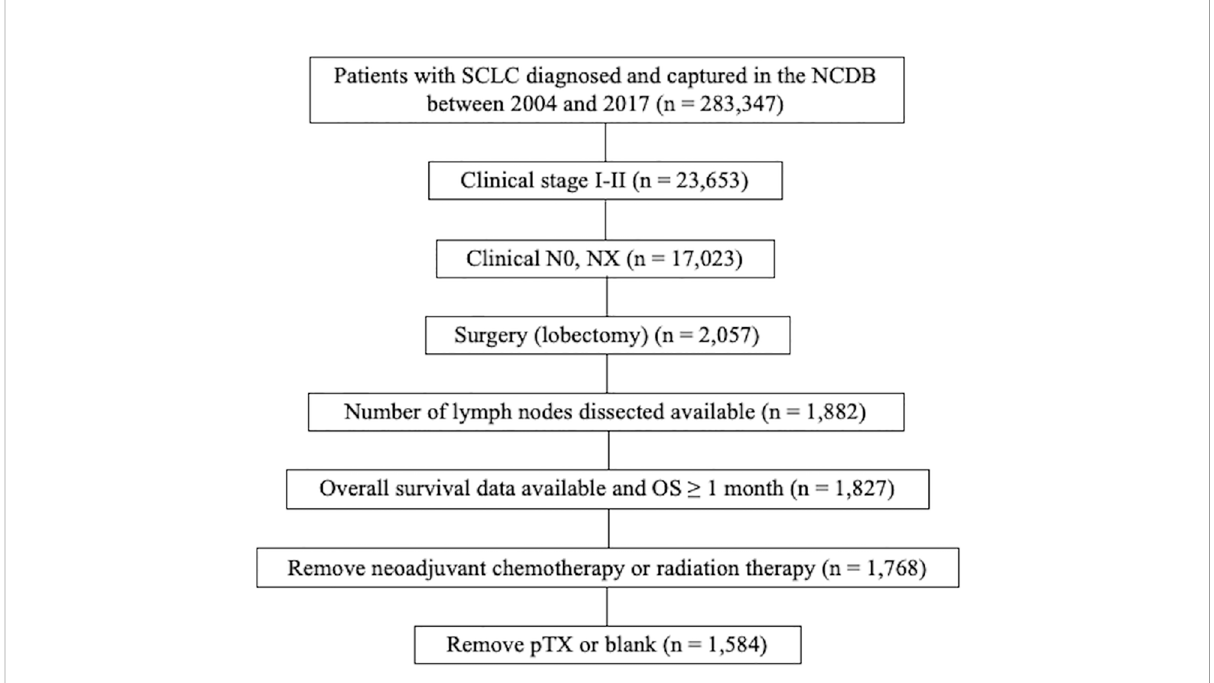
FIGURE 1 Study fl ow diagram of case eligibility. SCLC, small cell lung cancer; NCDB, National Cancer Database; AJCC, American Joint commission on cancer; OS, overall